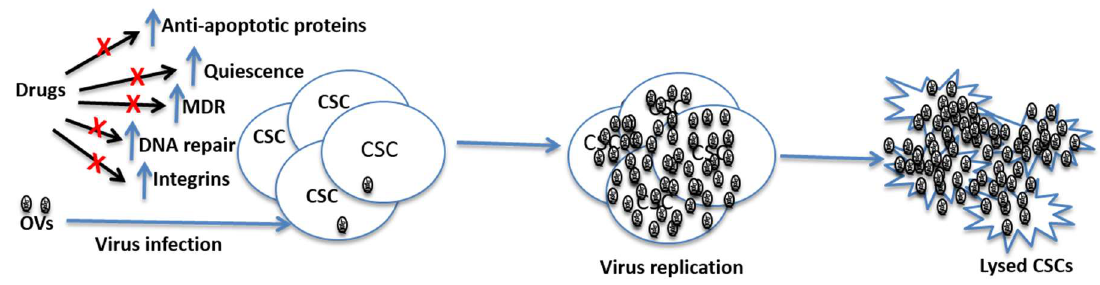
Figure 2. Potential mechanisms through which CSCs can resist conventional therapies, and prospects of OVs in killing such cells. CSCs have high levels of MDR expression, increased DNA repair ability and they can maintain quiescence for a long time. These features of CSCs can render chemotherapeutic drugs ineffective in killing them. However, oncolytic viruses are not affected by these features and hence they can replicate in CSCs leading the lysis of these cells. Note: OVs = Oncolytic viruses; MDR = multi -rug resistance gene; CSCs = cancer stem cells.